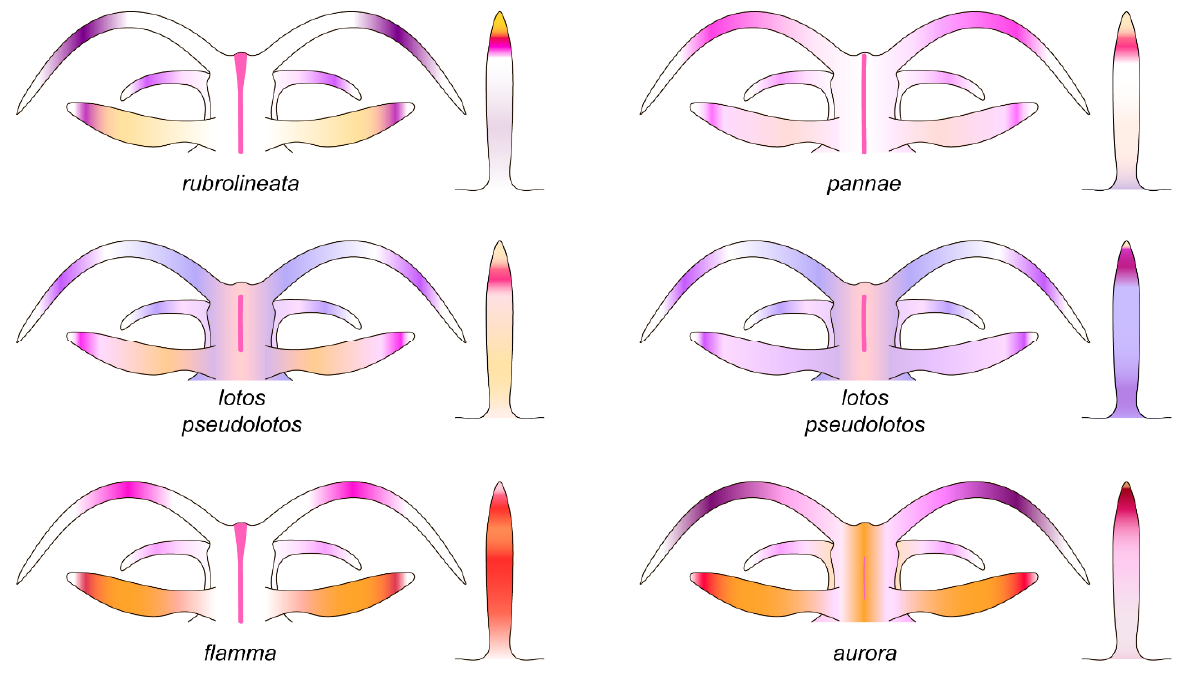
Figure 4. Diagrams of the color pattern of head region and cerata in Coryphellina rubrolineata species complex.